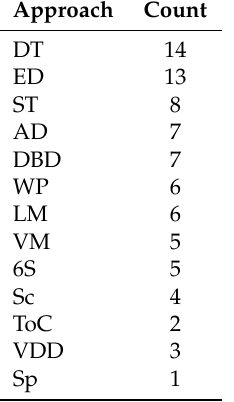
Table 8. Number of respondents selecting and rating each approach, ordered by decreasing count.